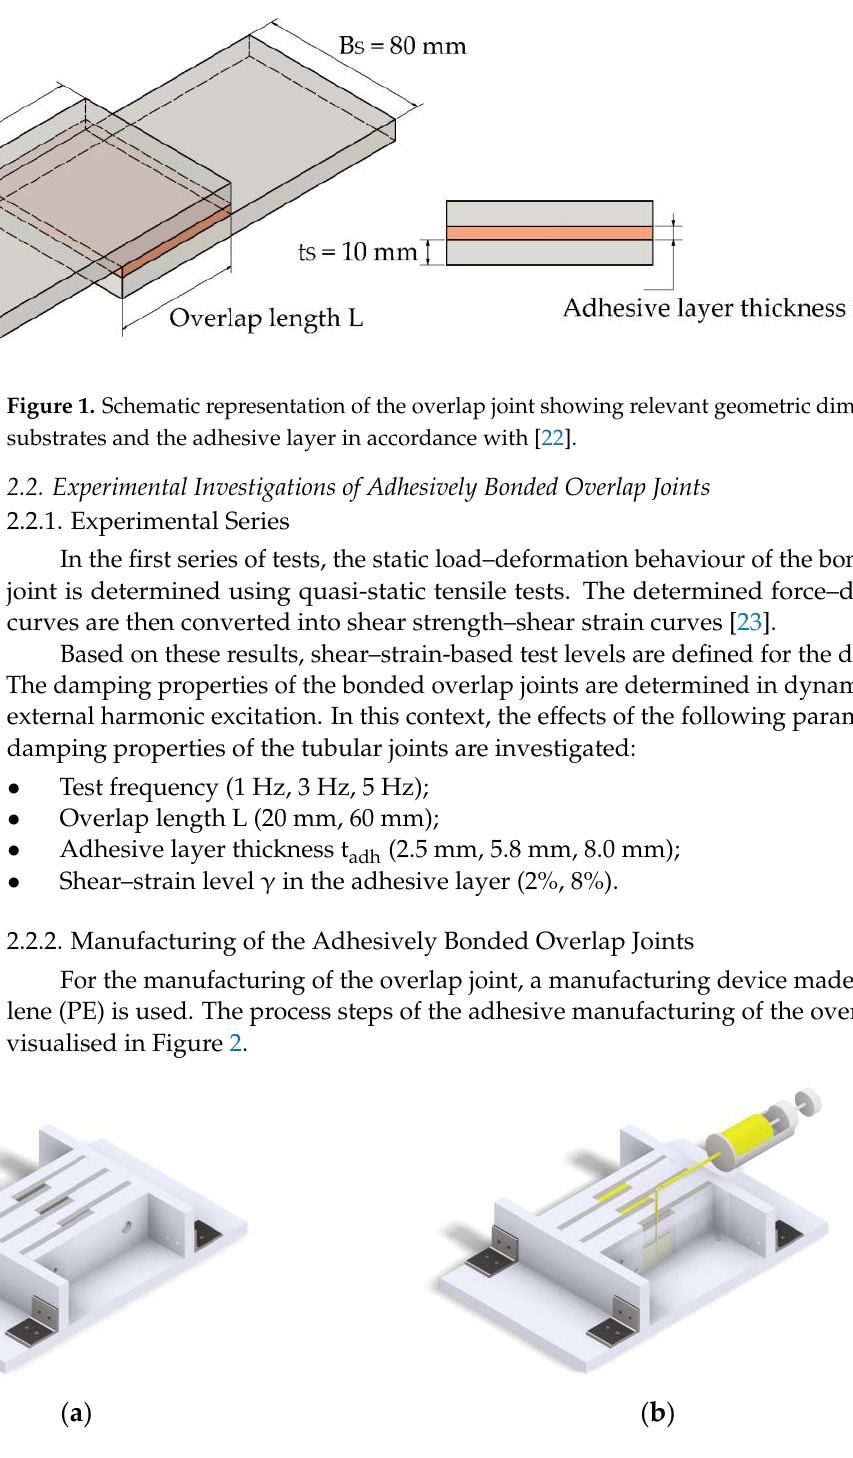
Figure 1. Schematic representation of the overlap joint showing relevant geometric dimensions of the substrates and the adhesive layer in accordance with [22.]